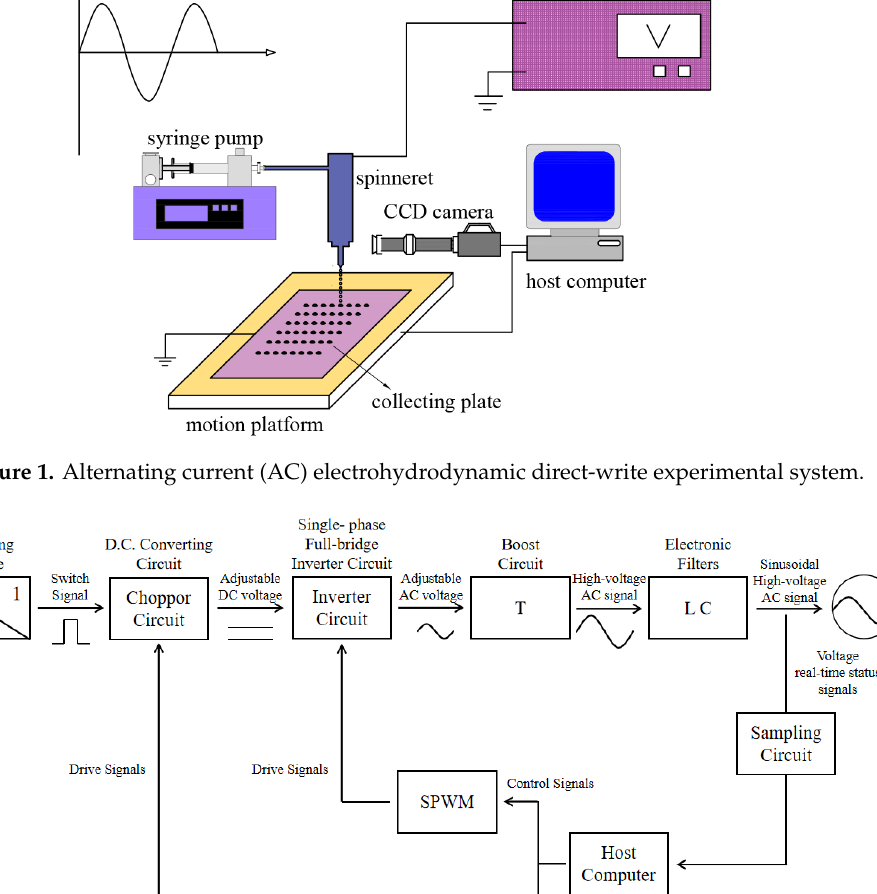
Figure 1. Alternating current (AC) electrohydrodynamic direct-write experimental system.